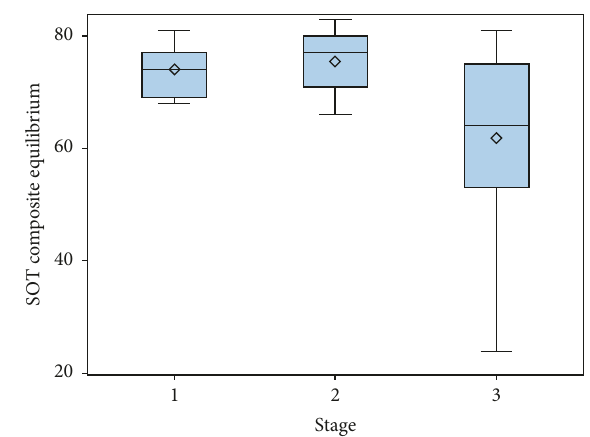
Figure 3: Comparative boxplot of sensory organization test composite equilibrium score for Parkinson’s disease and age- matched healthy cohorts.